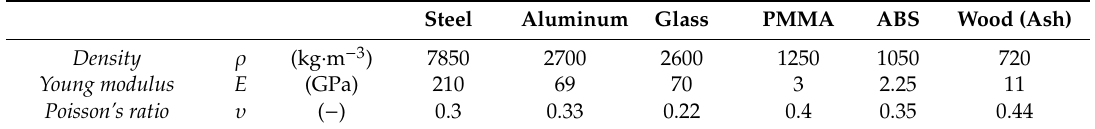
Table 2. Mechanical properties of used materials [39–42].